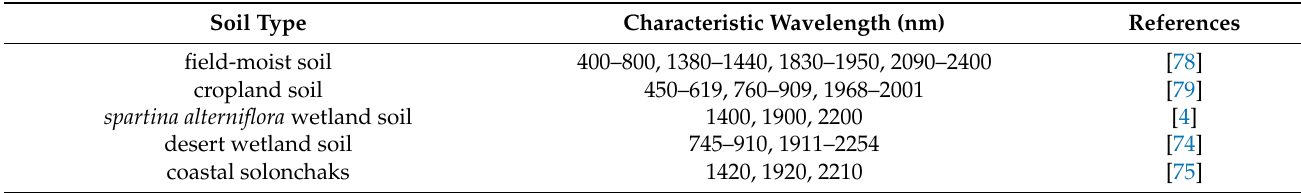
Table 4. SOC characteristic wavelengths for different types of